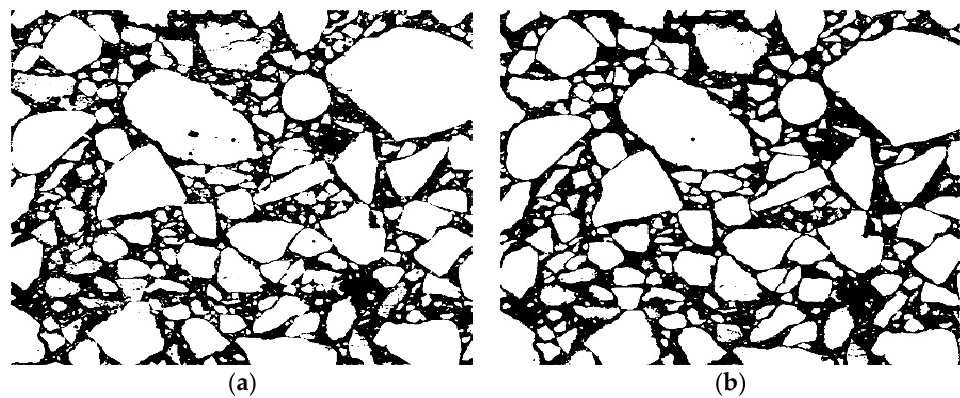
Figure 8. ( a ) A binary image after threshold; ( b ) after applying watershed splitting filter with erosion/dilation functions.